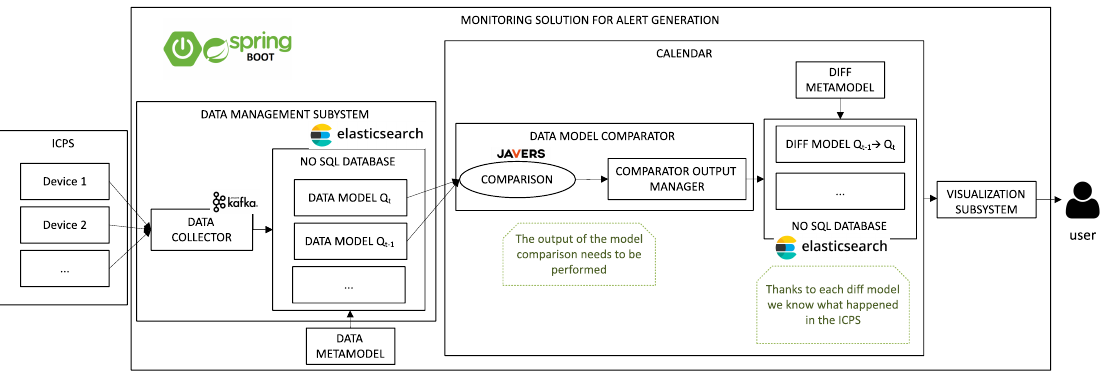
Figure 2. A real scenario of monitoring ICPS, detecting the evolution, and alerting